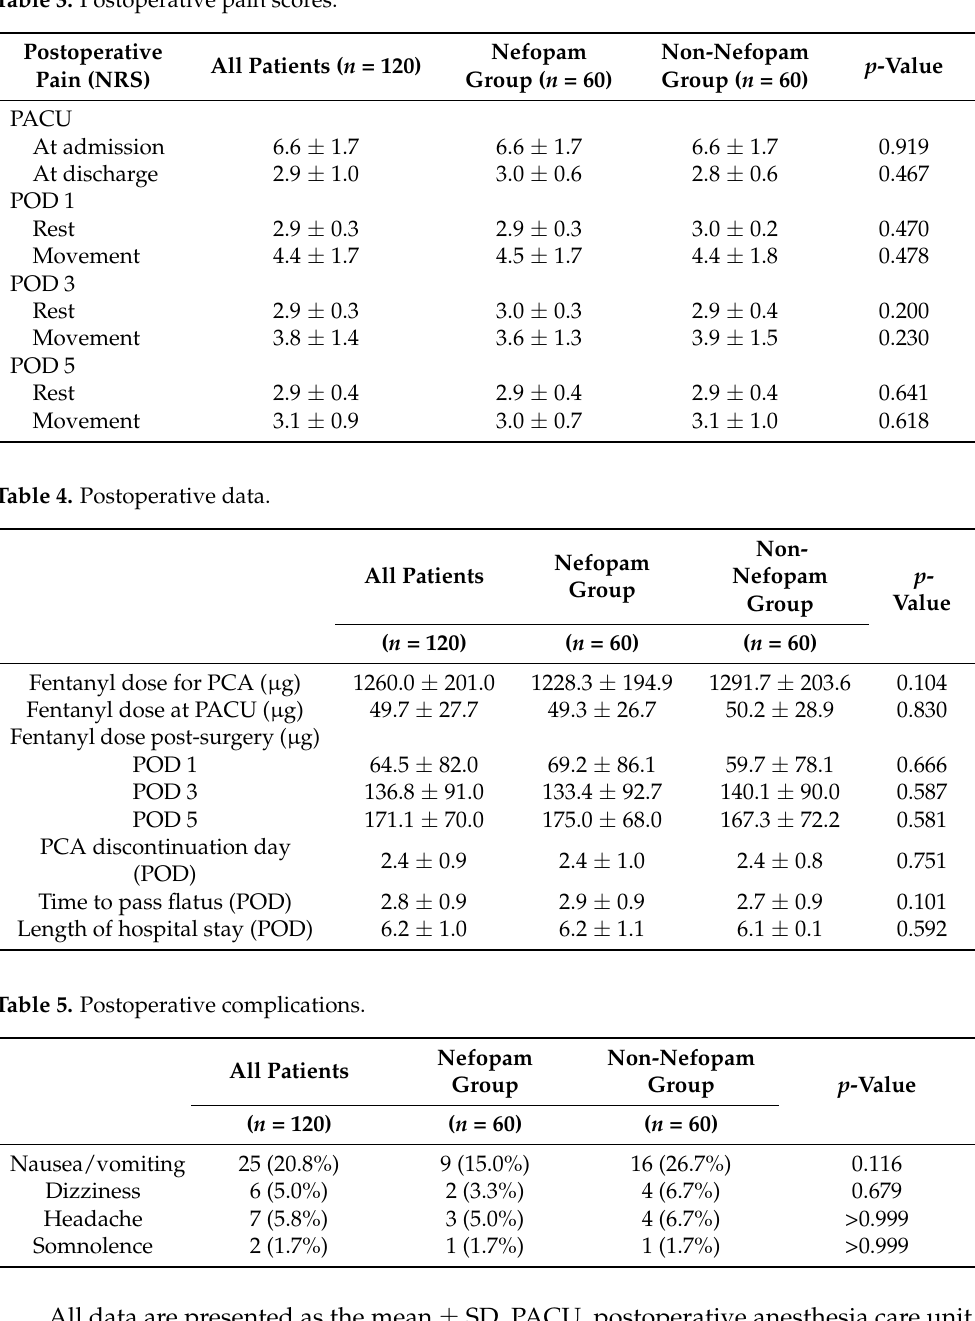
Table 3. Postoperative pain scores.